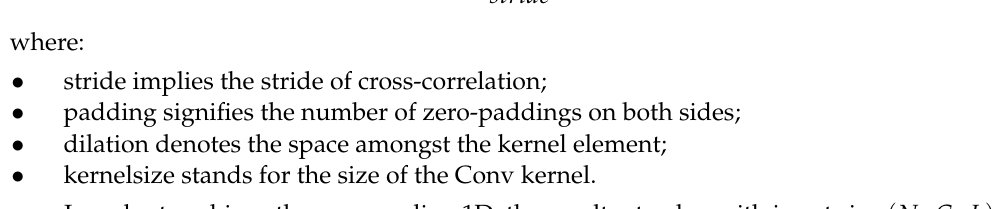
Figure 2. Structure of CNN.